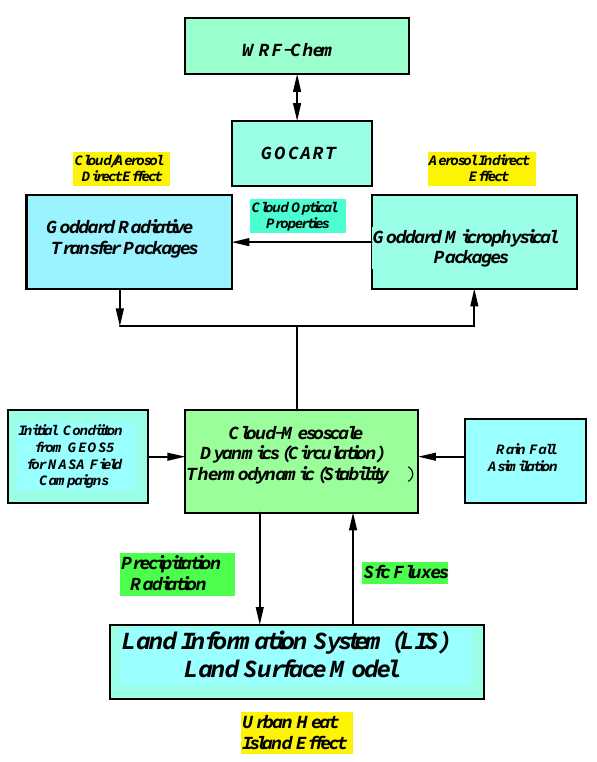
Fig. 1 Schematic diagram showing planned components of the NASA unified WRF. The blue boxes Fig. 1. Schematic diagram showing planned components of the represent physical processes (packages) developed by NASA scientists. The light green boxes NASA unified WRF. The blue boxes represent physical processes represent the WRF dynamical core and others (i.e., NCAR) developed outside of NASA. (packages) developed by NASA scientists. The light green boxes GOCART stands for Goddard Chemistry Aerosol Radiation and Transport model. represent the WRF dynamical core and others (i.e., NCAR) devel- oped outside of NASA. GOCART stands for Goddard Chemistry Aerosol Radiation and Transport